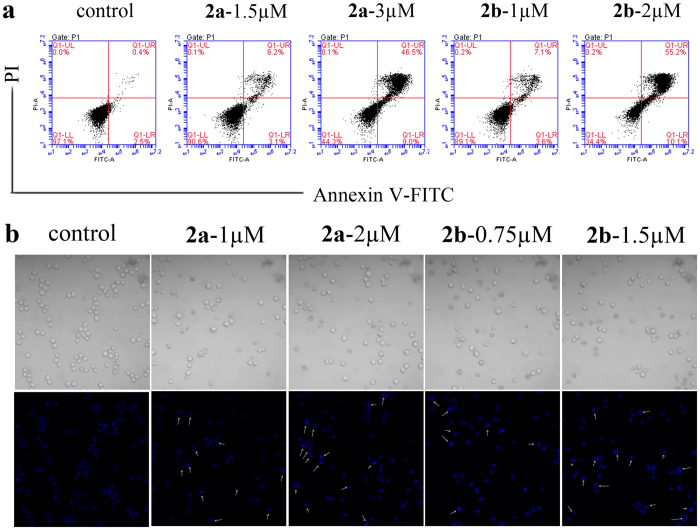
Induction of apoptosis in HL-60 cells in vitro.(a) The results of apoptosis by Annexin V-FITC/PI double-staining assay. HL-60 cells were treated with compound 2a (1.5 μM and 3 μM) or 2b (1 μM and 2 μM) for 24 h, then stained by Annexin V-FITC and PI dye. There are four kinds of cell populations shown as follows: live cells population (lower left), early apoptotic cells (lower right), late apoptotic cells (upper right) and dead cells (upper left). (b) Analysis of morphology changes in HL-60 cells. HL-60 cells were treated with 2a (1 μM and 2 μM) or 2b (0.75 μM and 1.5 μM) for 24 h followed by Hoechst 33342 staining. Phase contrast (top) and fluorescence (bottom) images were acquired by fluorescence microscopy. The apoptotic cells are shown with white arrows. These experiment were performed more than three times.